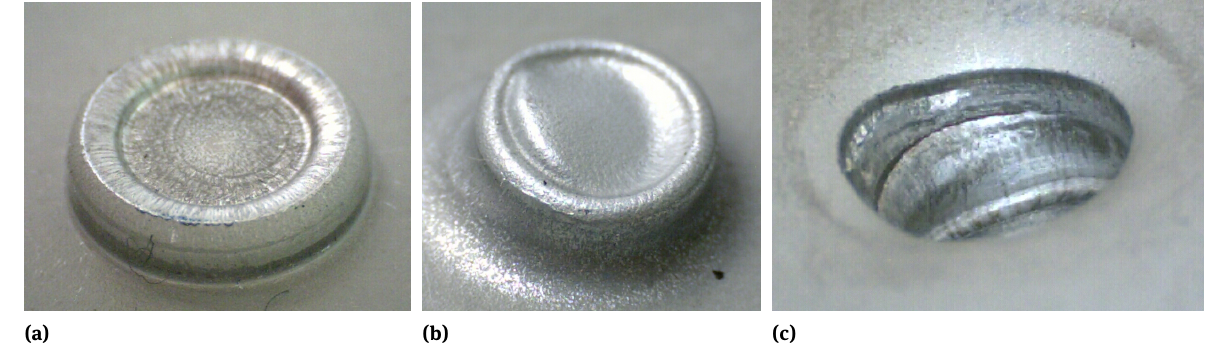
Figure 8: Clinched joint with DC06 sheets after tensile test: (a) bottom sheet, (b) middle sheet, (c) top sheet.